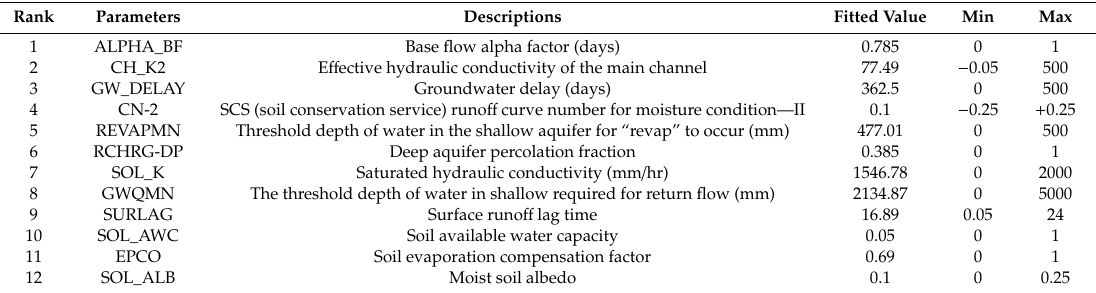
Table 4. Result of the sensitivity analysis parameters of streamflow [sensitivity parameters maximum, minimum, and fitted values using Sequential Uncertainty Fitting version-2